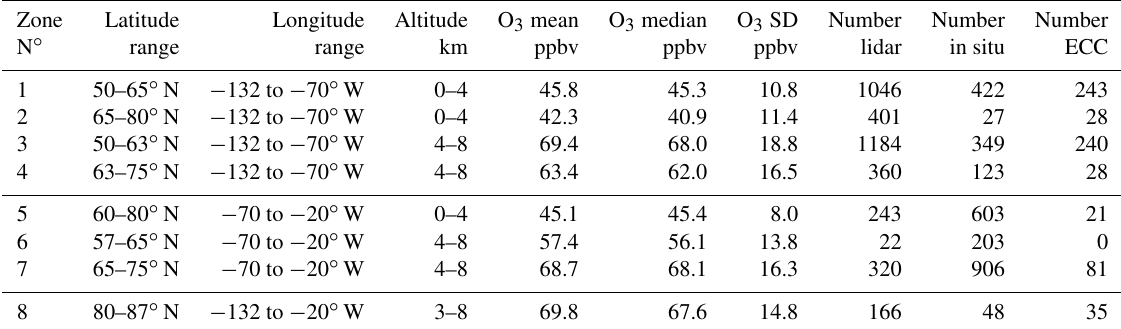
Figure 3. Latitudinal cross section of the measured ozone mixing ratio in ppbv over Canada (left panel) and over Greenland (right panel). The red bars show the location of ozonesonde stations. Black regions with O 3 > 160ppbv correspond to the stratosphere. Table 3. Mean, median, and standard deviation of the observed ozone mixing ratio in the different boxes shown in Figs. 7 and 9, except for the two boxes at latitudes > 80 ◦ N, which have been merged in the last row of the